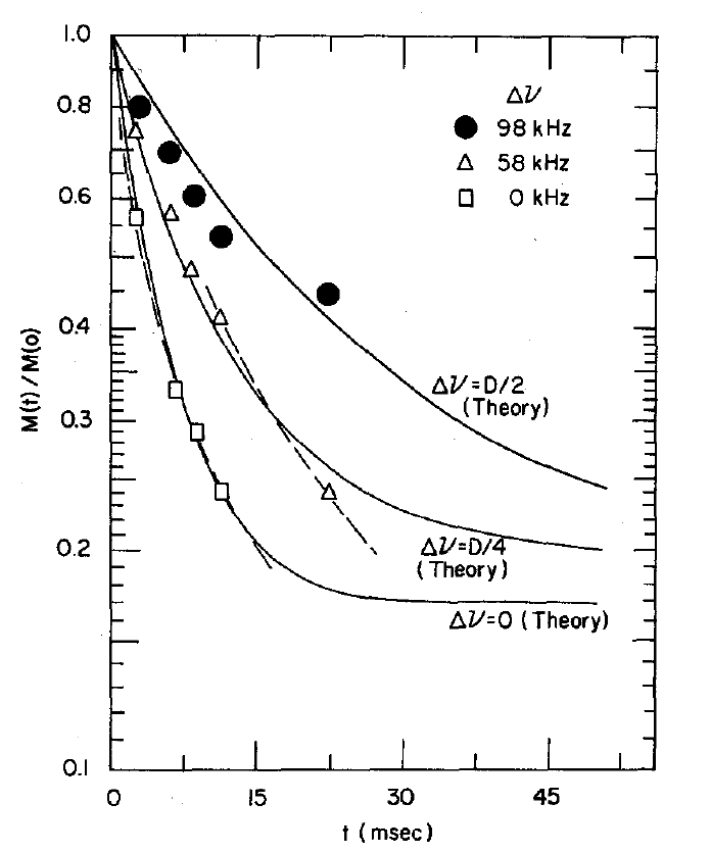
Figure 15. Observed nuclear spin-lattice relaxation in the form of multi-exponentials in the glass state of solid ortho-para hydrogen mixtures. Reproduced with permission from [47]. Copyright Springer Nature,